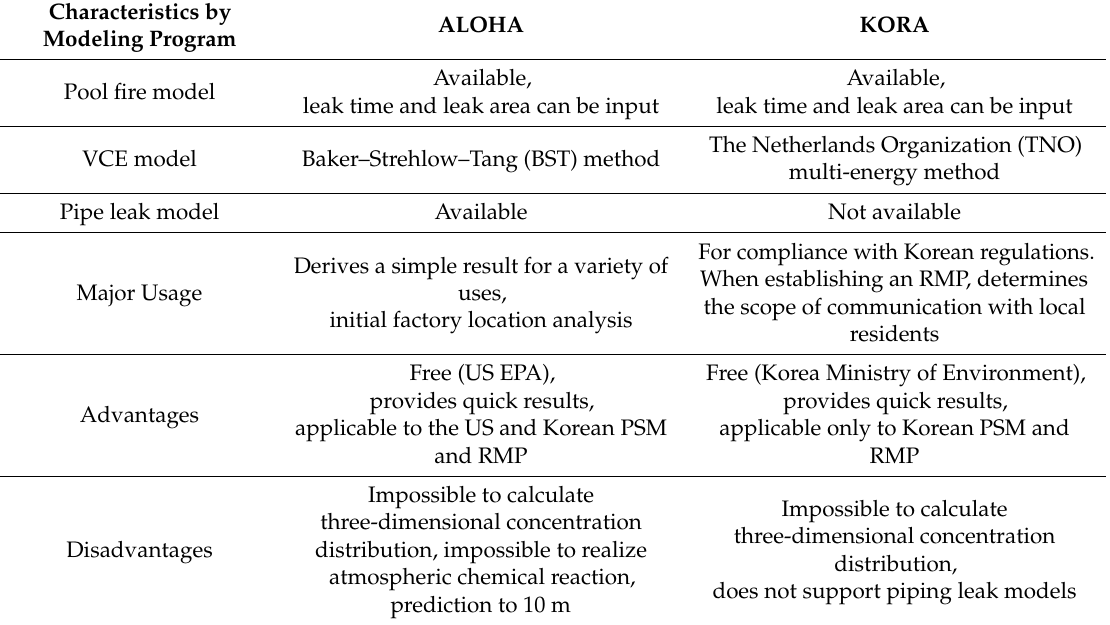
Table 5. Characteristics, advantages, and disadvantages of risk assessment tools. ALOHA, Areal Location of Hazardous Atmosphere; KORA, Korea O ff -Site Risk Assessment Supporting